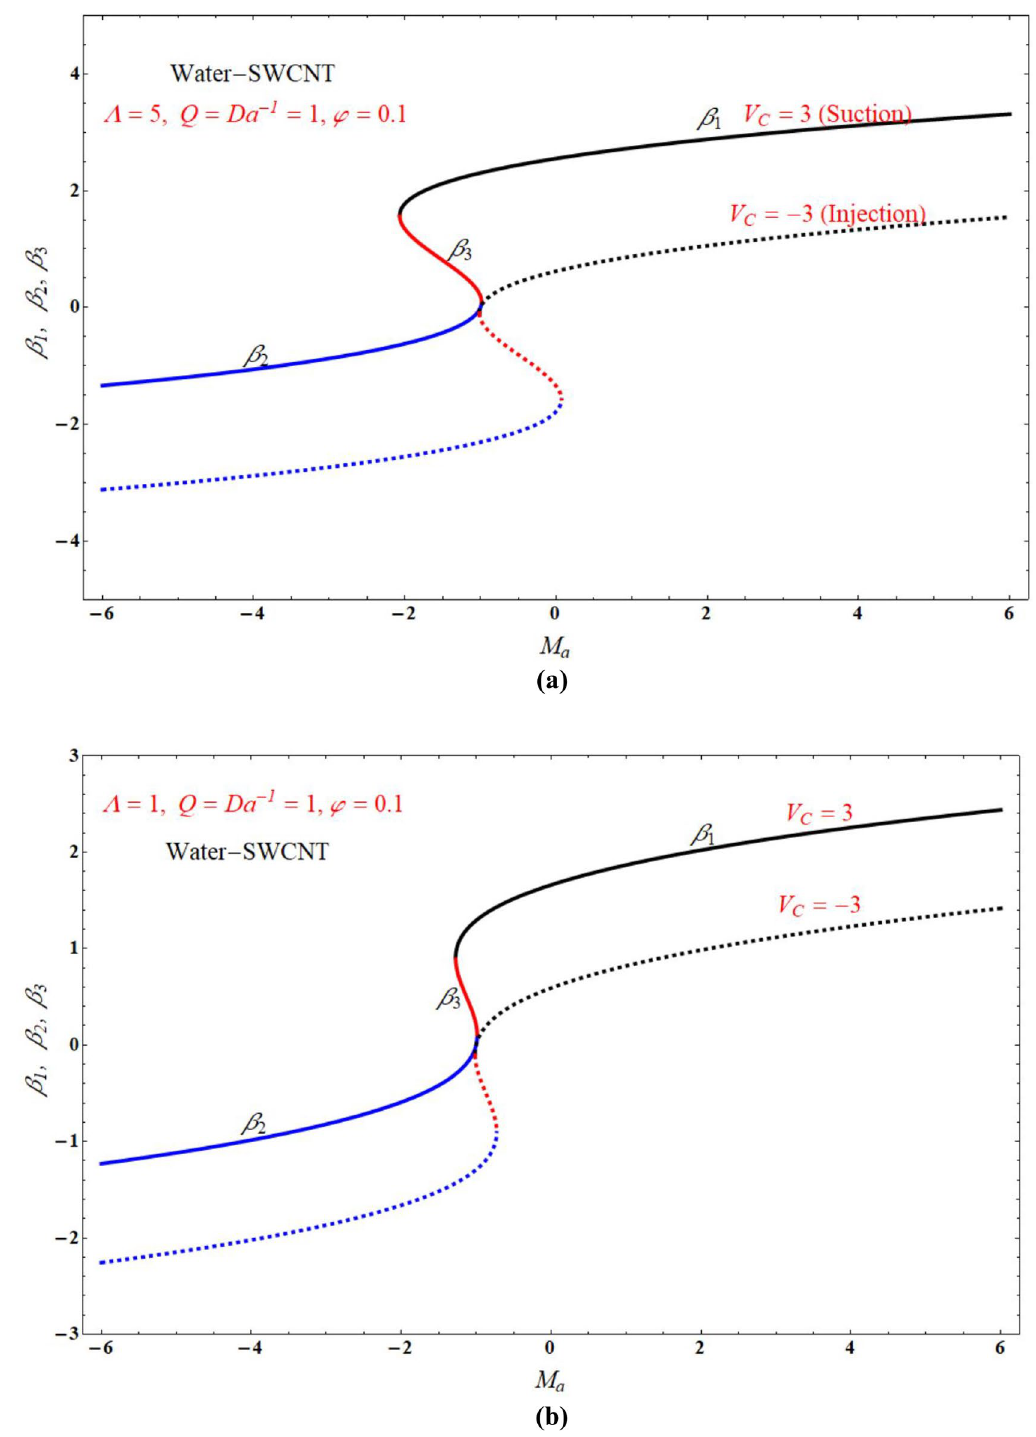
Figure 2. The plots of β 1 , β 2 , β 3 verses Ma for suction and injection cases at ( a ) (cid:31) = 5 , and ( b ) (cid:31) = 1